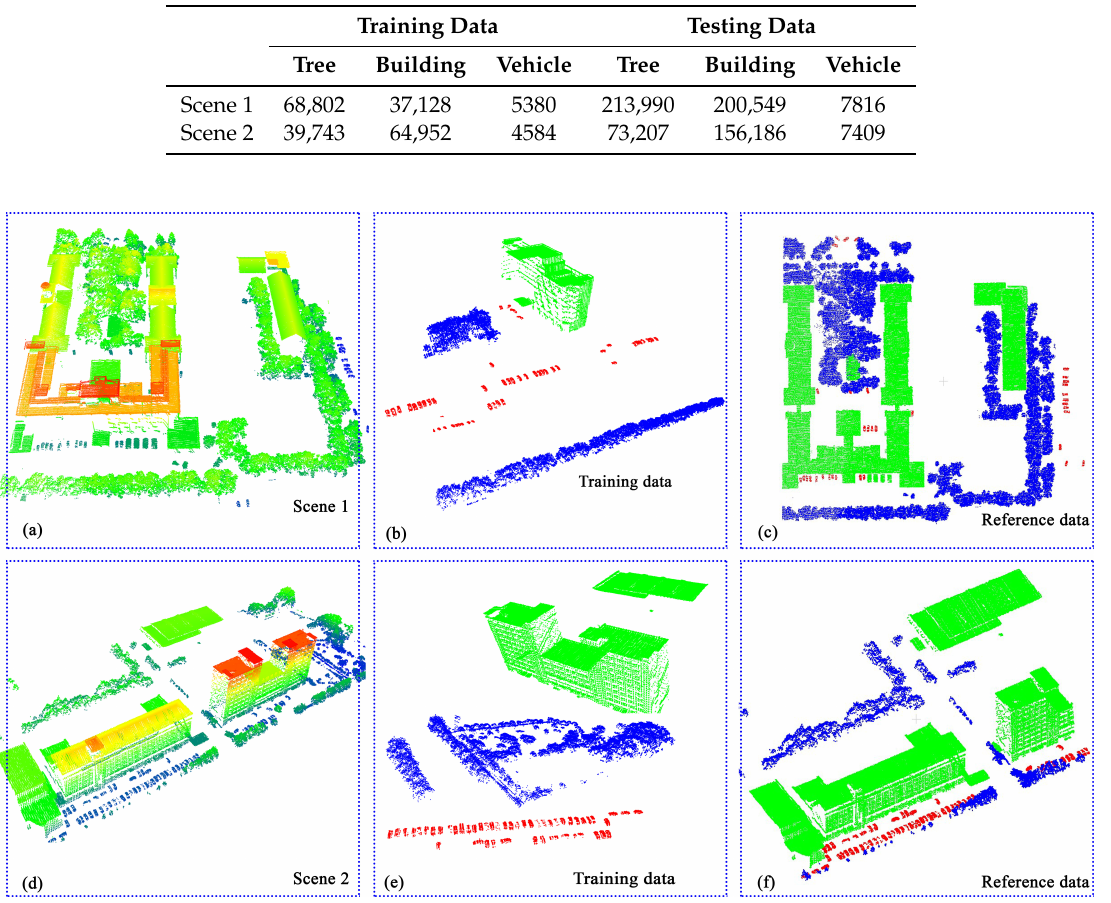
Table 1. The statistics of the training and testing datasets in Scenes 1 and 2.